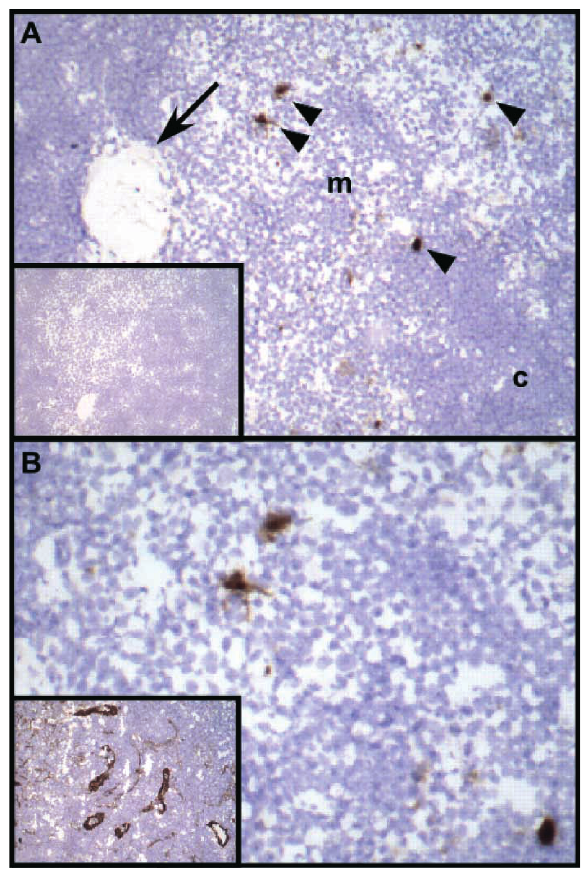
FIGURE 5 MAdCAM-1 is expressed in the thymus, but not by endothelial cells. MAdCAM-1 expression was examined by immunohistochemistry on thymus. Cells expressing MAdCAM-1 (arrowheads) are found within medullary (M) areas, but not in the cortex (C). For comparison, the location of a large post-capillary venule is indicated by an arrow. The inset shows an isotype-matched antibody control. Panel B shows a high power image of the central region in Panel A, illustrating the morphology of MAdCAM-1-expressing cells. The inset on Panel B shows MAdCAM-1 staining on mesenteric lymph node. Thymuses from animals of all ages tested showed similar results. Original magnifications: Panel A, 200 £ , Panel B, 400 £